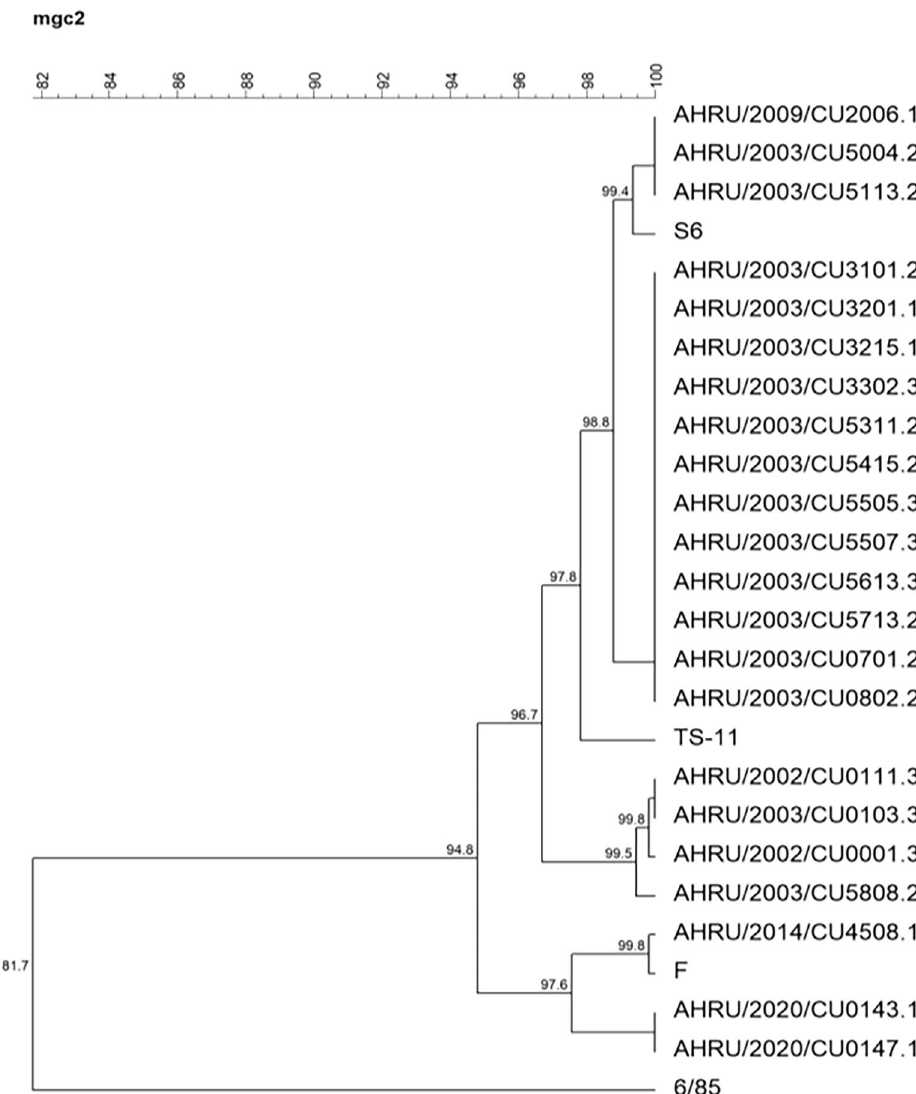
Figure 1. A phylogenetic tree of Thai MG and reference strains based on the alignment of the partial mgc2 gene was constructed with the unweighted pair group method with arithmetic mean (UPGMA) using Bionumeric version 7.6